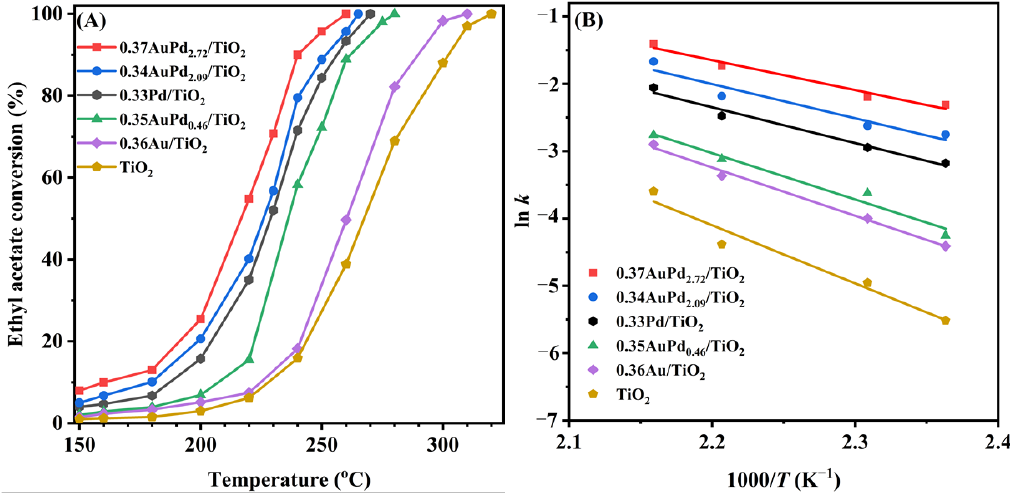
Figure 5 . ( A ) Ethyl acetate conversion as a function of temperature and ( B ) Arrhenius plots for ethyl acetate oxidation over the as-obtained samples at SV = 40,000 mL/(g h).